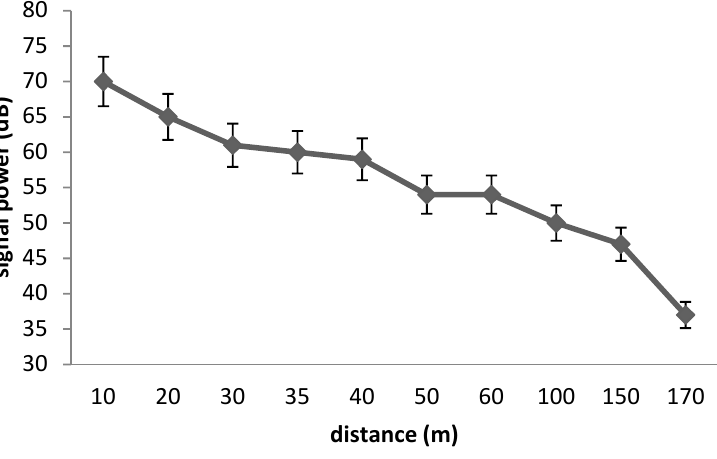
Figure 4. Relation between distance and signal power for a V13 tag under a rock.